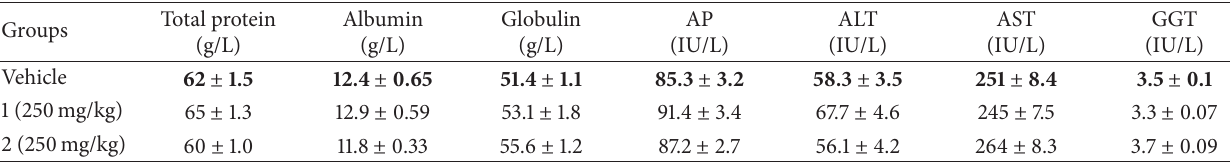
Values are expressed as the means ± S.E.M. There are no statistically significant differences between the measurements of different groups. Significance was set at 𝑃 < 0.05